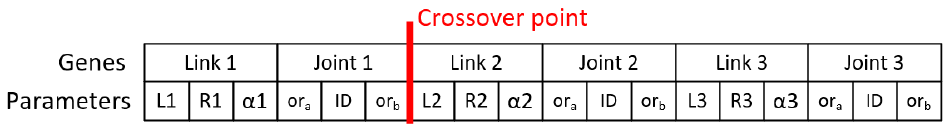
Figure 5. An example of a chromosome with a highlighted crossover point.